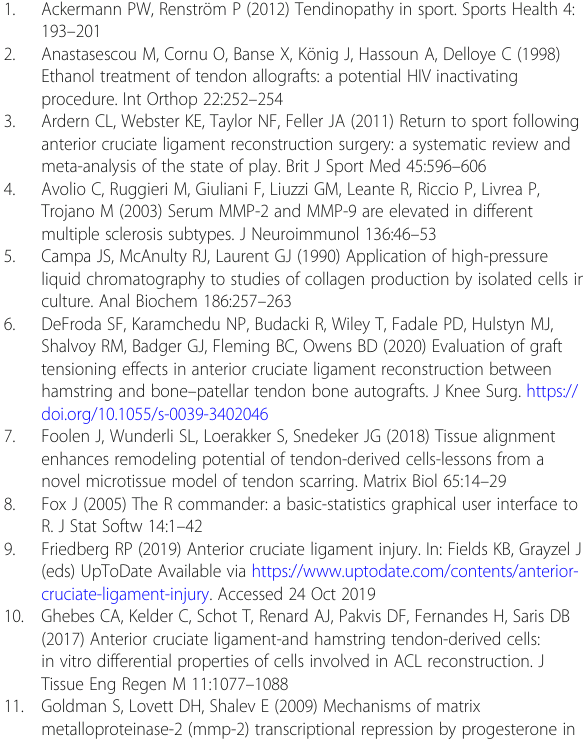
Additional file 1: Figure S1. Top-view surface areas over time. Top- view surface areas over time of all micro-tissues. Micro-tissues releasing from the posts are indicated with a cross (×). Additional file 2: Figure S2. Western blot protein bands. (A) Protein bands in Western blot for α SMA and tubulin (housekeeping protein). (B) Protein bands in Western blot for tenomodulin and tubulin (housekeeping protein). (C) Protein bands in Western blot for tubulin to check cell lysate content of ELISA-samples. (D) Boxplot of semi-quantified tubulin protein band intensities, with identified outliers. Additional file 3: Figure S3. Zymograph bands. Protein bands in gelatinase zymography for active MMP2 and inactive (pro-)MMP2. Additional file 4: Table S1. Patient